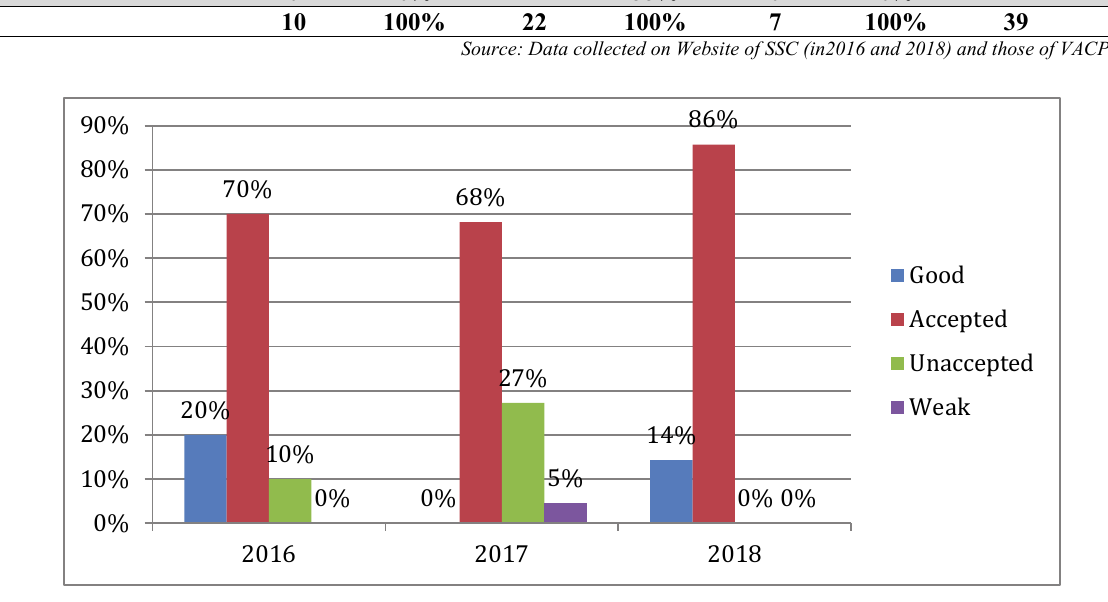
Fig 2. Results of classification in quality from 2016 to 2018 Source: Data collected on Website of SSC (in 2016 and 2018) and those of VACPA (in